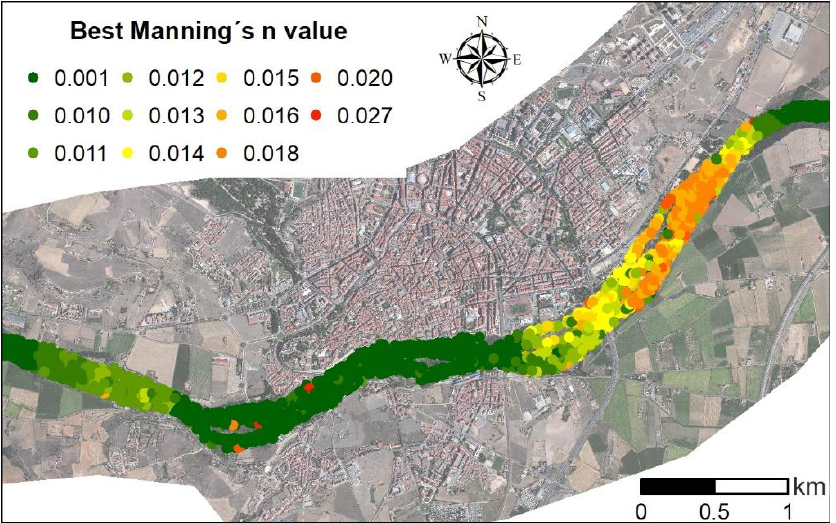
Figure 5. Map showing the spatial distribution of the Manning’s n value best fit option along the Douro River channel in Zamora city, Spain. The Manning’s n value best fit was found from the relationship between the channel bathymetry differences (“real scenario”–“LiDAR scenario”) and the flow depth differences.